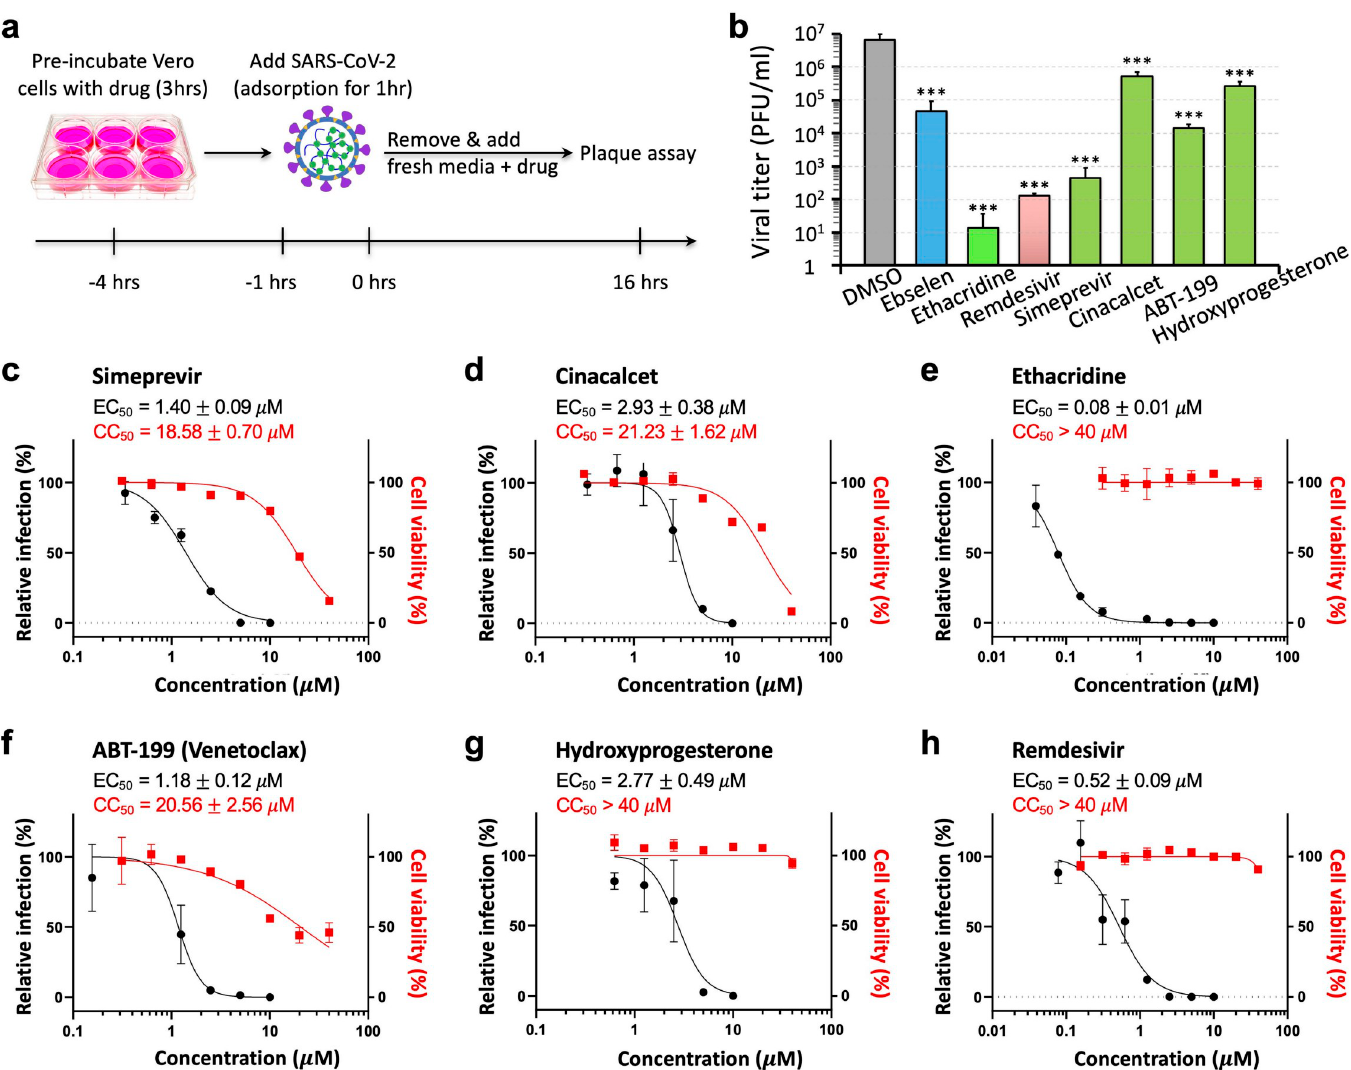
Fig 3. Antiviral activities of the identified drugs against SARS-CoV-2. ( a ) Schematic showing the experimental design, see Methods for details. ( b ) Quantitative analysis of viral titer from plaque assays on Vero E6 cells treated with each drug at 5 μ M. Data are mean ± SEM (n = 3). ��� p < 0.001. ( c–h ) Dose-response and cell-toxicity curve of each drug against SARS-CoV-2 by plaque assays. The percentage of relative infection was determined by the ratio of infection rate of SARS-CoV-2 treated with each drug divided by that of DMSO control. EC50 and CC50 are represented as mean ± SEM (n =